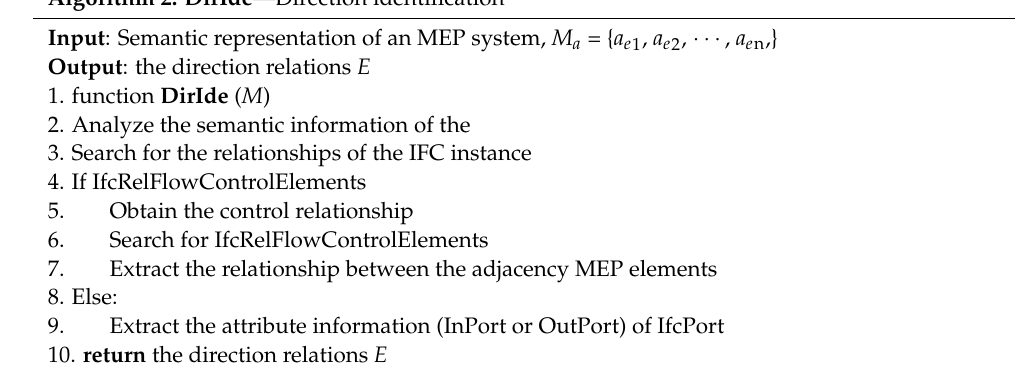
Figure 15. The direction relationships of a part of MEP system. Algorithm 2 summarizes the main process of the direction identification. Line 2 ex- tracts topological connection relationships among IFC instances, lines 3–7 extract directions based on the control relationship, and lines 9–12 identify directions based on the upstream and downstream relationships. Algorithm 2: DirIde —Direction